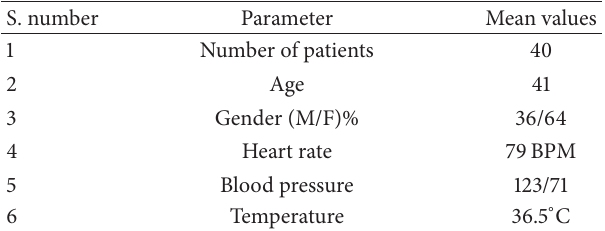
Table 3: Mean value of patient